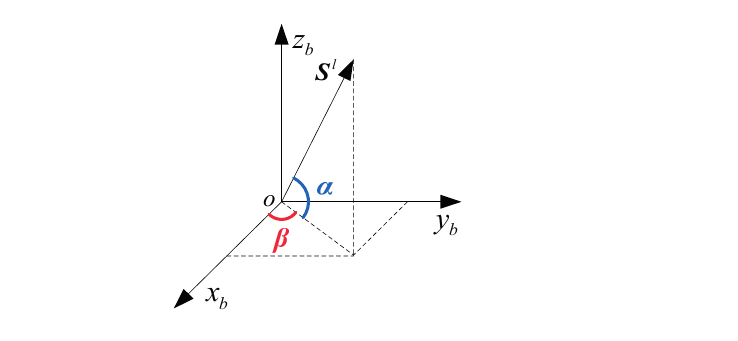
Figure 2. Projection of gyro sensitive axis in the body coordinate system.